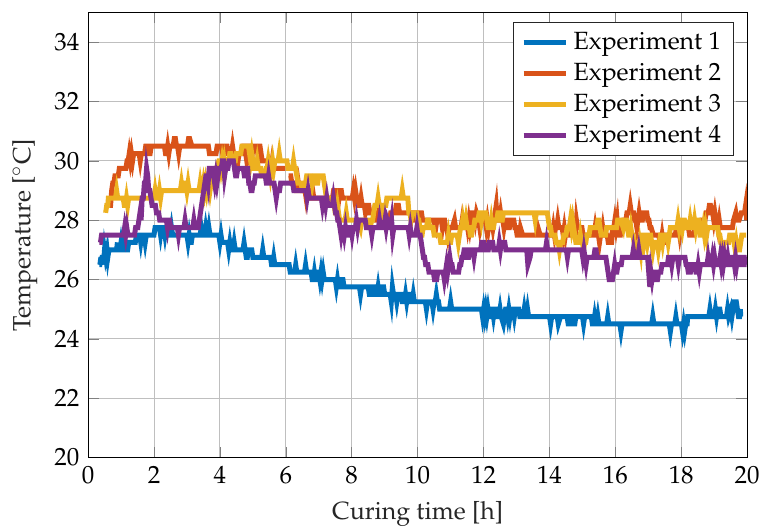
Figure 5. Temperature development during the curing reaction of RIMR 426 resin with RIMH 435 curing agent measured with a type K